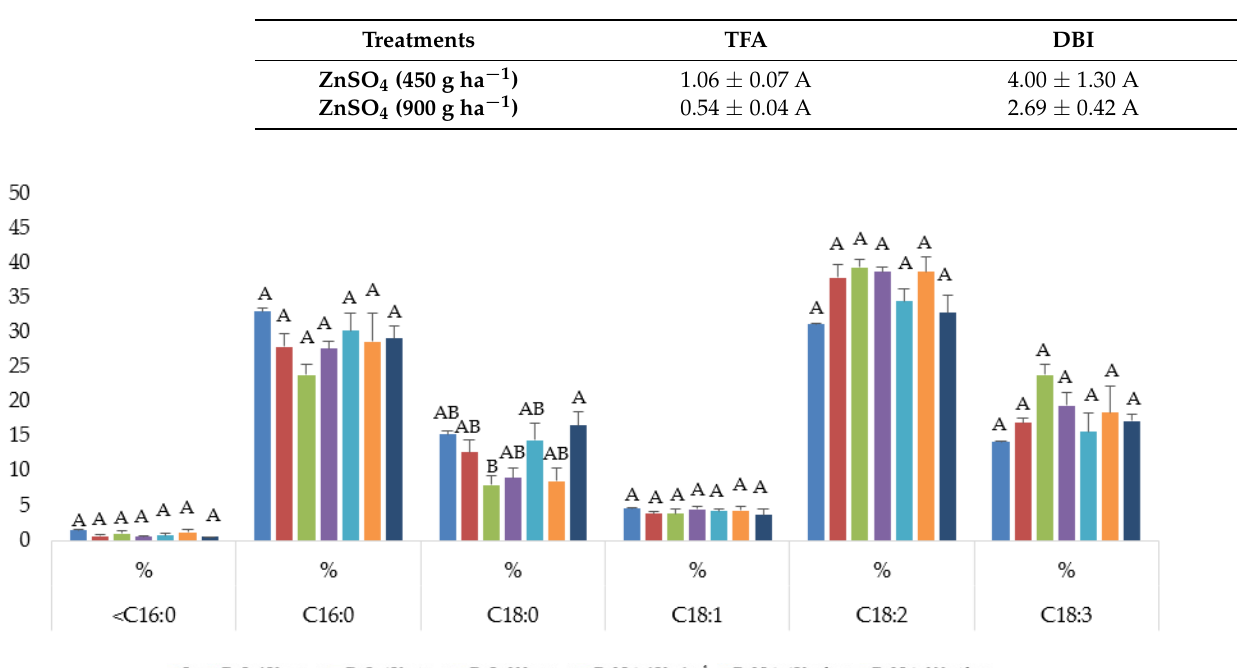
Figure 2. Mean values ± SE (n = 3) of fatty acid profile (mol %) in grape berry lipids of Vitis vinifera L. variety Fernão Pires at harvest. Letters A and B indicate significant differences between treatments (statistical analysis using the single-factor ANOVA test, p ≤ 0.05).